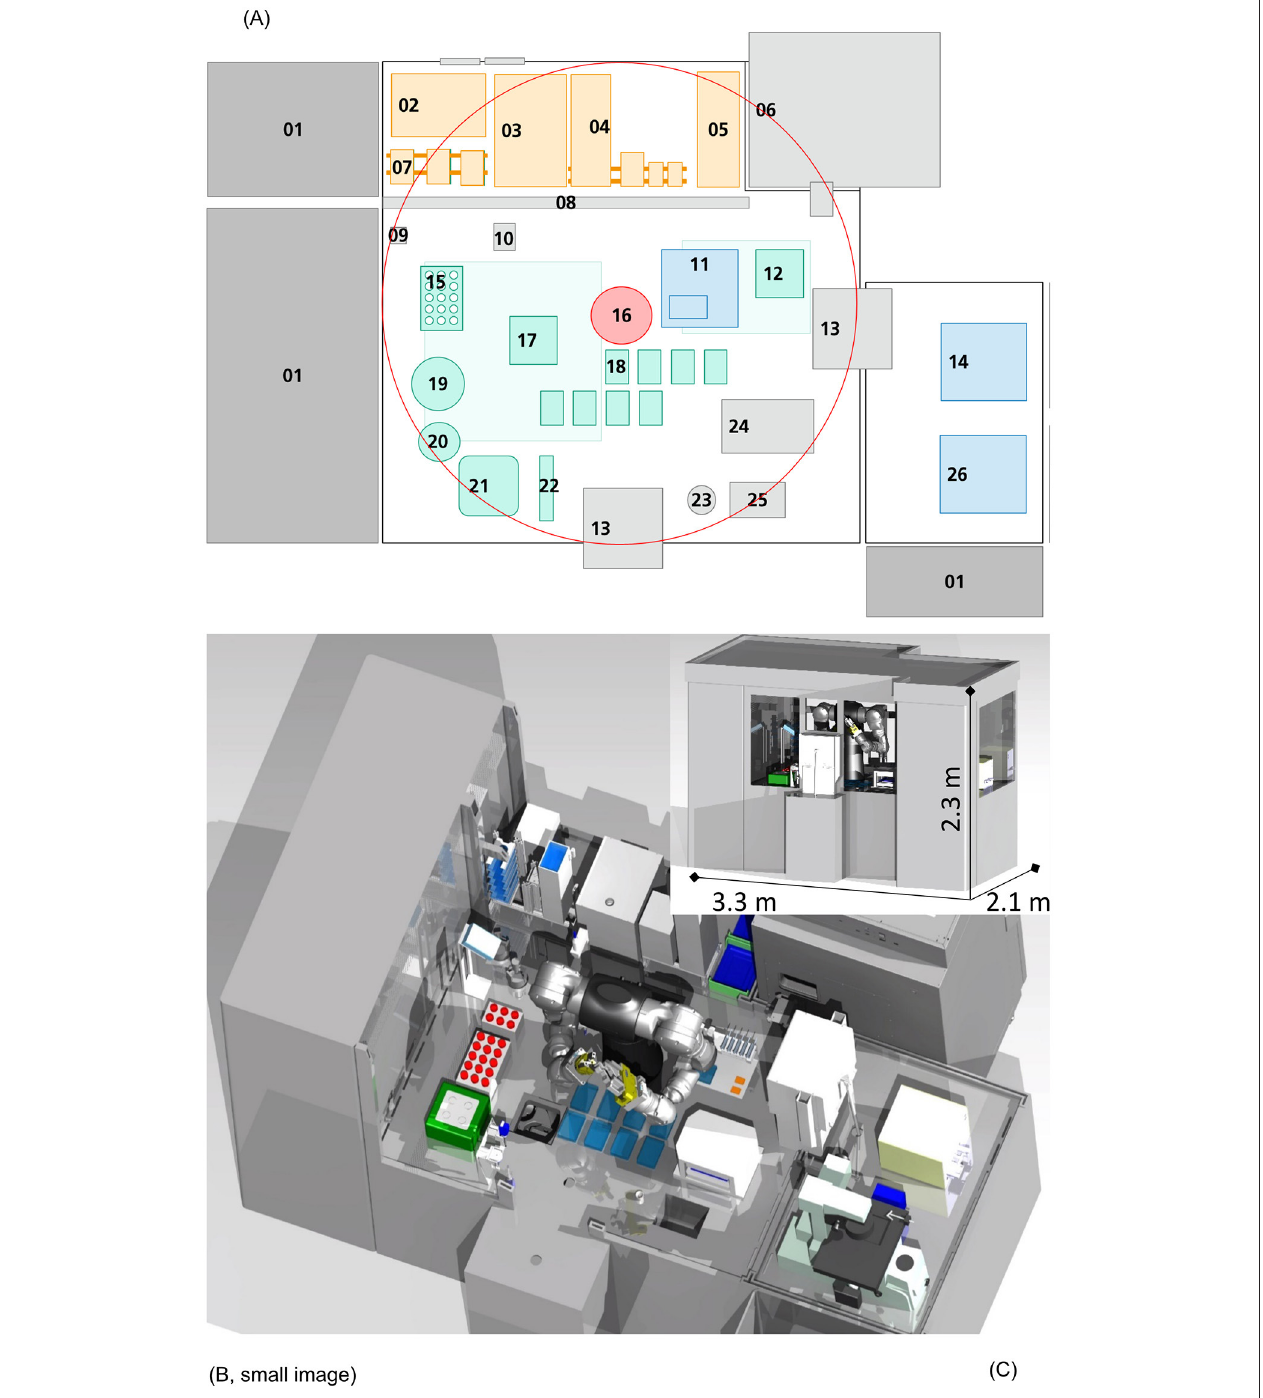
FIGURE 2 | Automation scheme and visual representation. In this figure, a 2D (A) and 3D [ (B) : frontal view, (C) : sliced view] representation of this concept is shown. The platform is equipped with devices for each handling step: 01 Ventilation system, 02 Freezer ( − 20 ◦ C), 03 Fridge (4 ◦ C), 04 Disposables storage, 05 Packaging material, 06 Incubator (37 ◦ C), 07 Storage for plates and membranes, 08 Gate, 09 Barcode reader, 10 Washing station, 11 Sampling station, 12 Shaker, 13 Air-lock, 14 Cell counting device, 15 Storage for Cell culture tubes (temperature controlled), 16 Six axis dual arm robot, 17 Centrifuge, 18 Plate handling positions, 19 Decapper (centrifuge flask), 20 Decapper (Cell culture tubes), 21 Tissue grinder, 22 Pipettes, 23 Liquid waste, 24 Sealing machine, 25 Solid waste, 26 Microscope. The central six axis dual arm robot (16) can reach the circumference shown in (A) . Necessary equipment, disposables and liquids are safely channeled in through an air lock linked glove box (orange), without the need of personnel entering the isolator directly from an unclassified maintenance back side. Pre-packed, sanitized